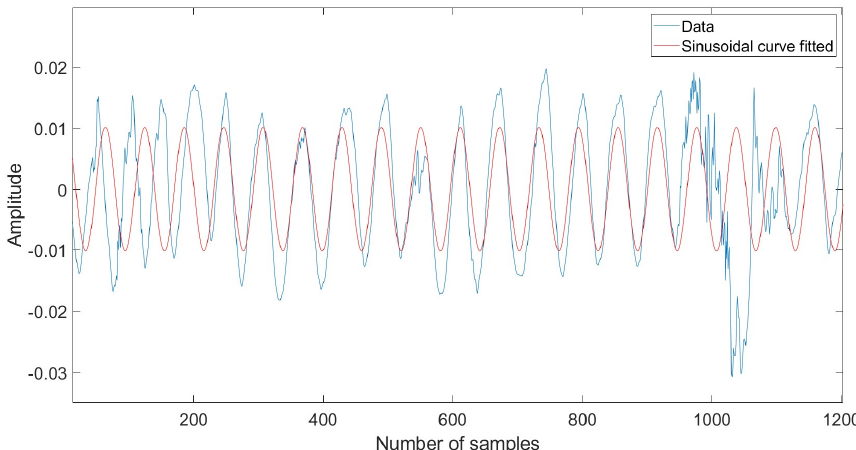
Sensors 2022 , 22 , x FOR PEER REVIEW Figure 4. Sample of signal with sine curve fit above threshold value. Figure 4. Sample of signal with sine curve fit above threshold value.